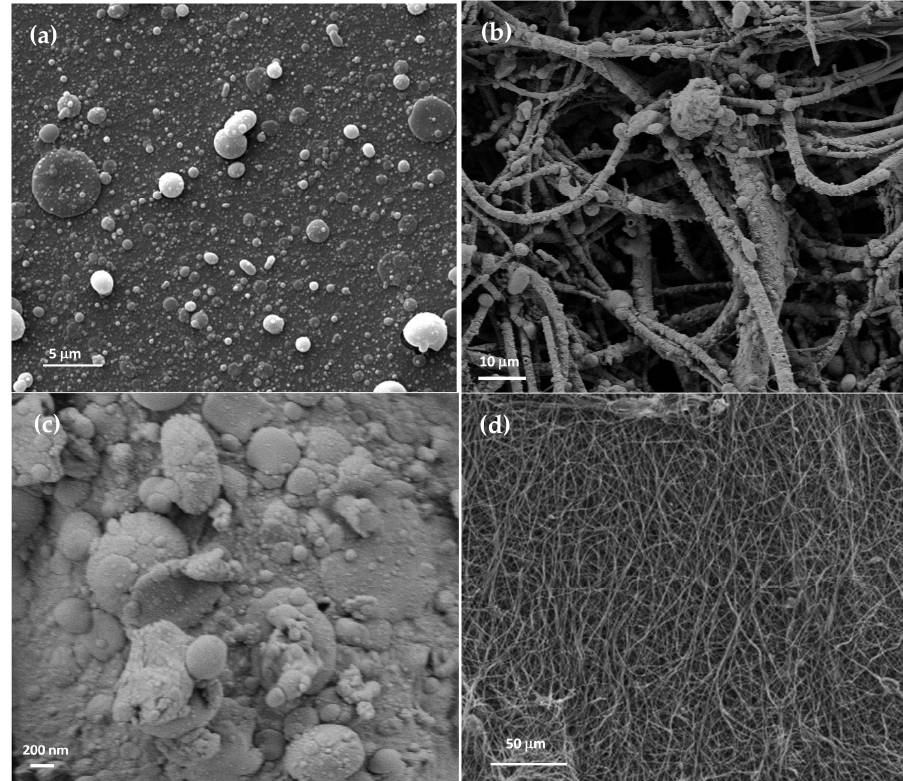
Figure 1. ( a ) SEM image of the Mn-BG coating deposited on silicon substrate. ( b , c ) SEM images of the Mn-BG coating deposited on the polymeric scaffold at two different magnification ( b ) 2500 × , ( c ) 50,000 × . ( d ) SEM image of the surface of the scaffold not exposed to the laser induced plasma.